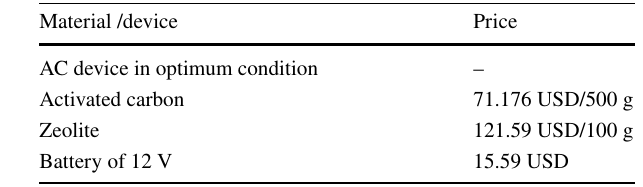
Table 10 Economic evaluation of EC process Material /device